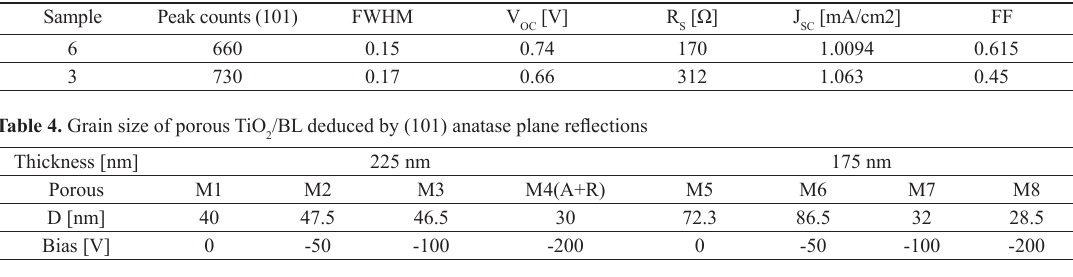
Table 3. Summarized data based on the XRD patterns and I(V) cell characteristics for sample numbers 3 and 6. Sample